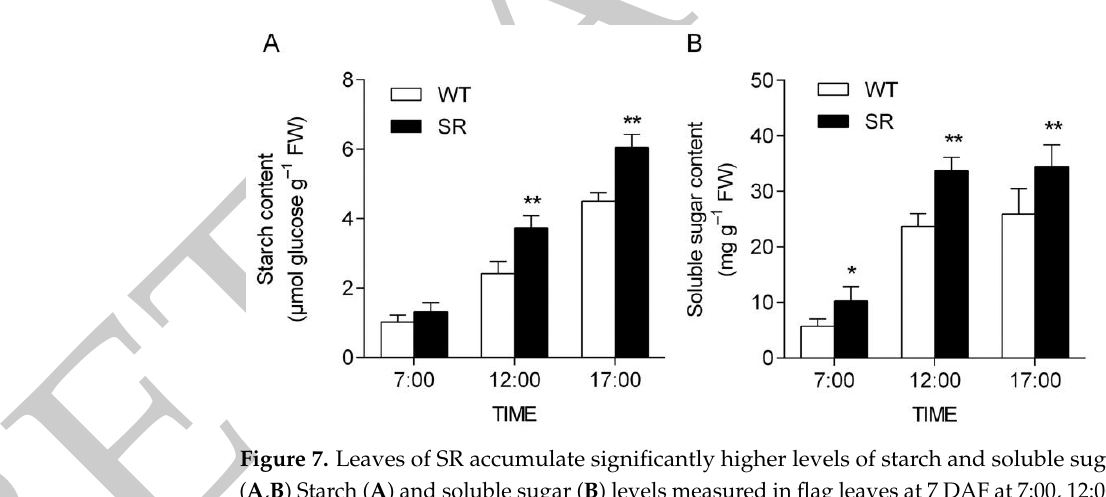
Figure 7. Leaves of SR accumulate significantly higher levels of starch and soluble sugar than WT. ( A , B ) Starch ( A ) and soluble sugar ( B ) levels measured in flag leaves at 7 DAF at 7:00, 12:00, and 17:00. Values ( A , B ) are given as means ± SD ( n = 6). Asterisks indicate significant differences between WT and SR. * p < 0.05; ** p < 0.01 compared with WT by Student’s t -test.